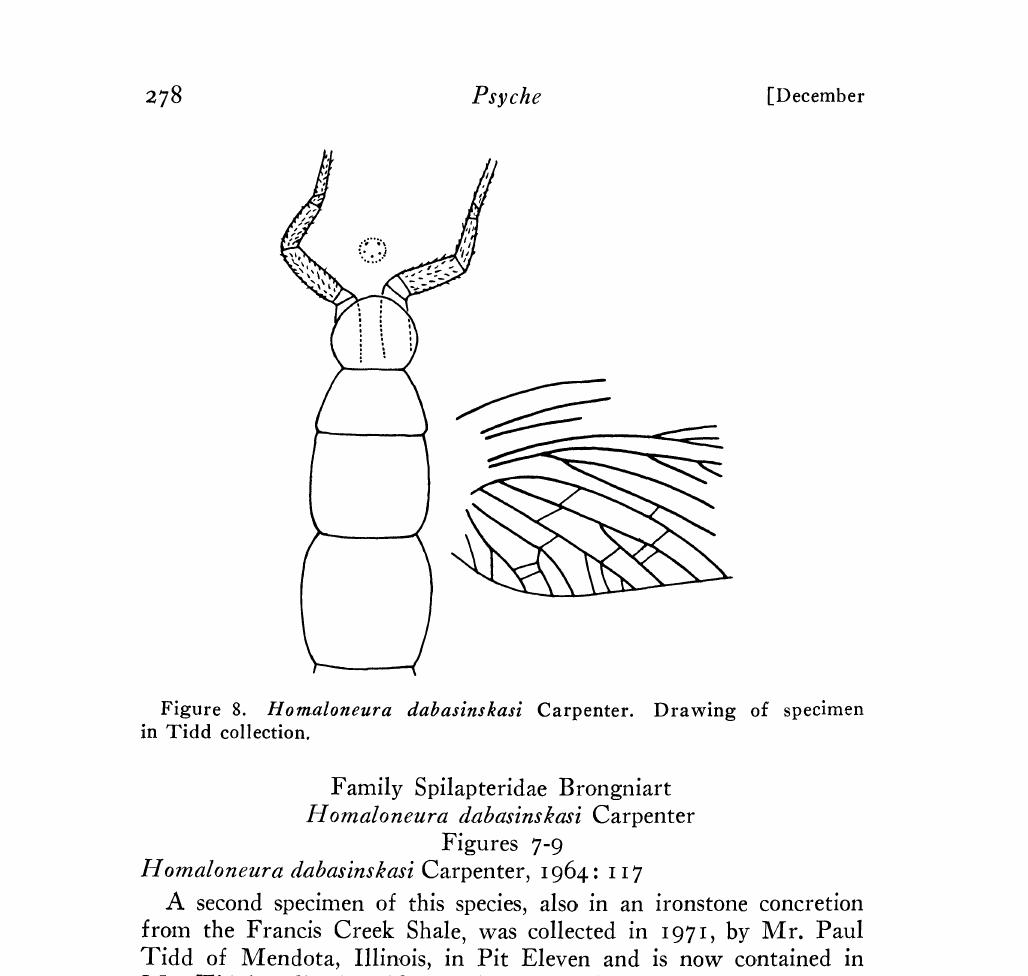
Figure 8. Homaloneura dabasinskasi Carpenter. Drawing o specimen in Tidd collection. Family Spilapterida.e